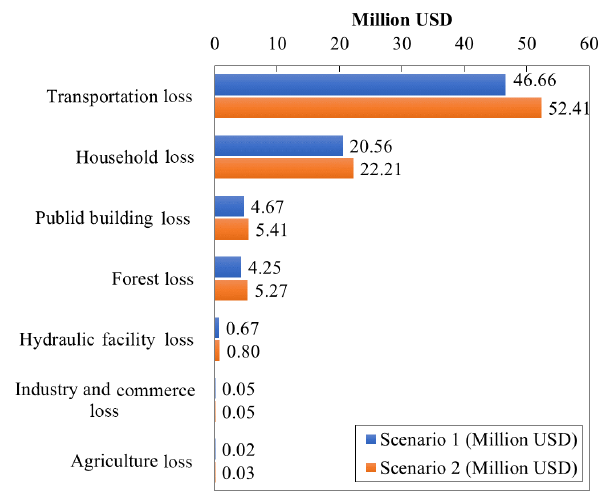
Figure 10. Direct losses.